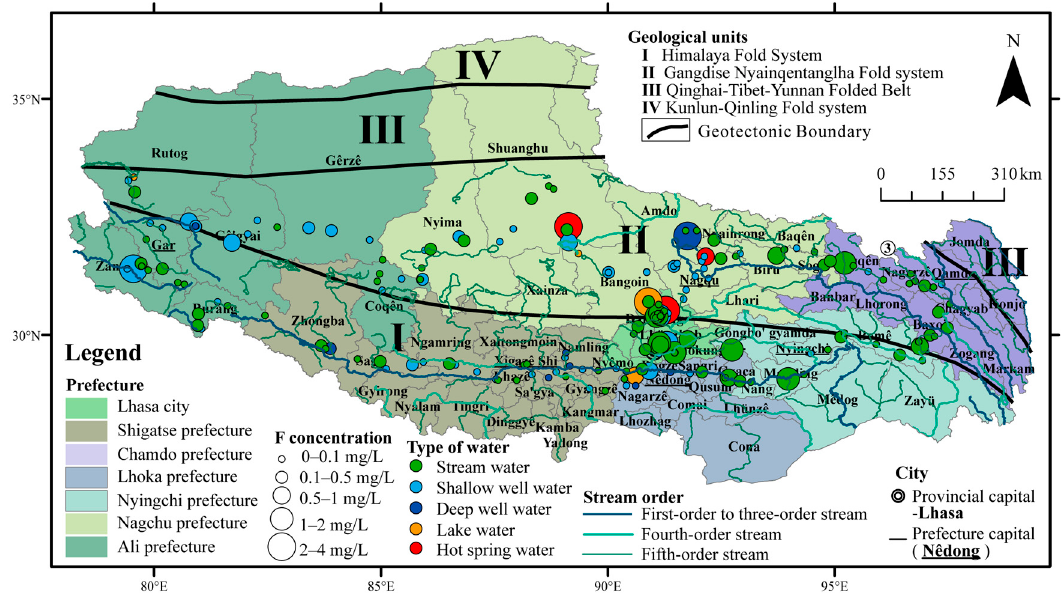
Figure 5. Administrative division, geological characteristics [26], and fluorine concentrations of different types of water in Tibet.